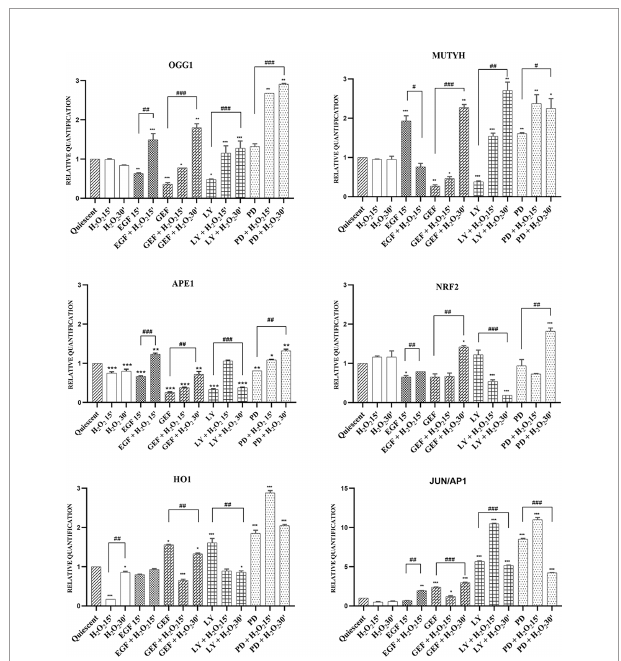
FIGURE 6 | mRNA expression of BER system in AGS cells. Total RNA was extracted from serum-starved cells untreated (Quiescent) and treated with 50 ng/mL EGF, 1 m M ge fi tinib (GEF), 25 m M LY294002 (LY), 50 m M PD98059 (PD), and/or 10 mM H 2 O 2 , for 15 and 30 min. Analysis was carried out by RT- qPCR, for mRNA expression of the OGG1 , MUTYH , APE1 , NRF2 , HO1 and JUN/AP1 genes (as indicated). As for gene expression analysis, data were calculated using the 2 − DD Ct method, normalized to GUSB ( b -glucuronidase) mRNA levels, and expressed relative to control (calibrator sample, de fi ned as 1.00). Data are expressed as means of three independent experiments. *p < 0.05; **p < 0.01; ***p < 0.001 (student ’ s t-tests, vs quiescent cells); # p < 0.05; ## p < 0.01; ### p < 0.001 (ANOVA followed by Bonferroni post-hoc test, within treatments). GEF, ge fi tinib; LY, LY294002; PD,